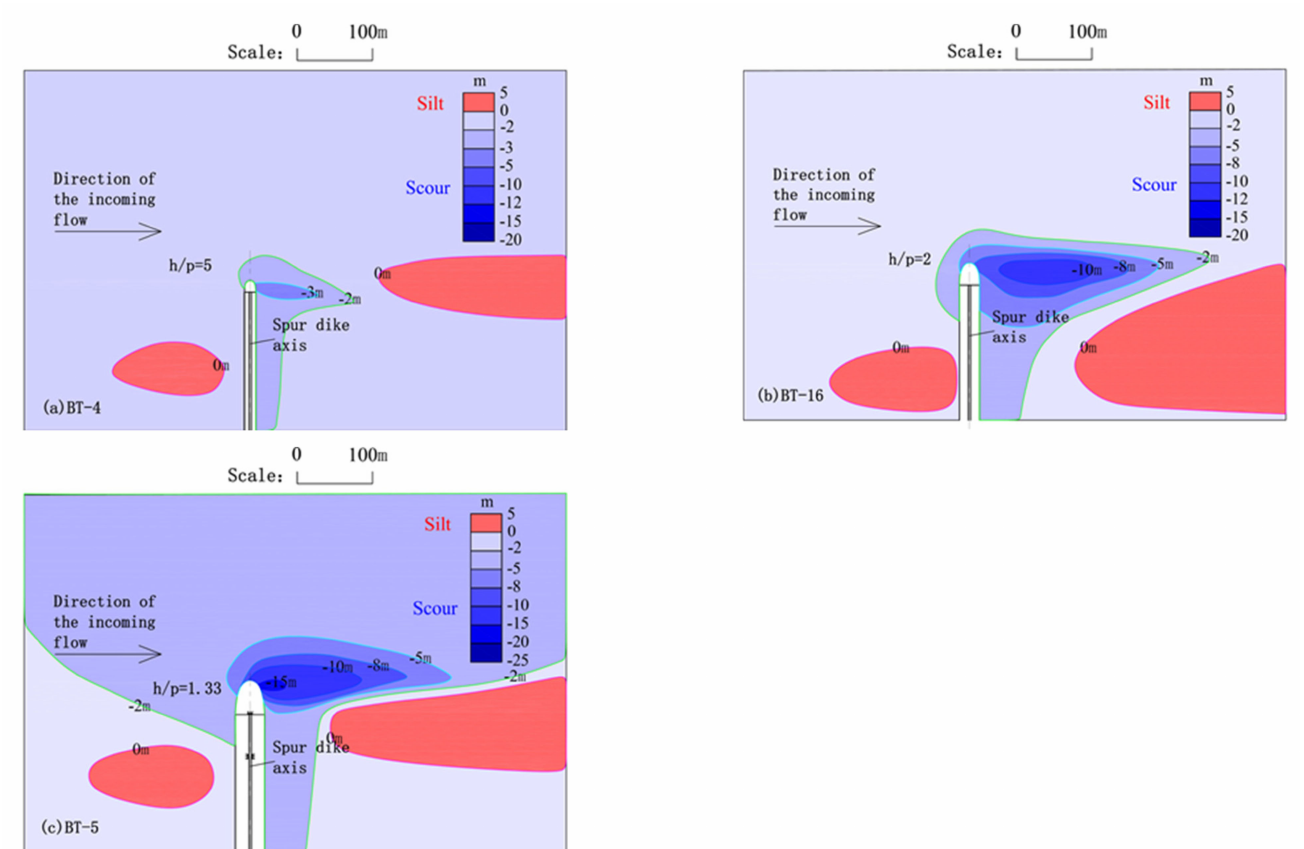
Figure 5. Relationship between the form of local scouring hole and height of dam: ( a ) when the h/p is equal to 5. ( b ) when the h/p is equal to 2; ( c ) when the h/p is equal to